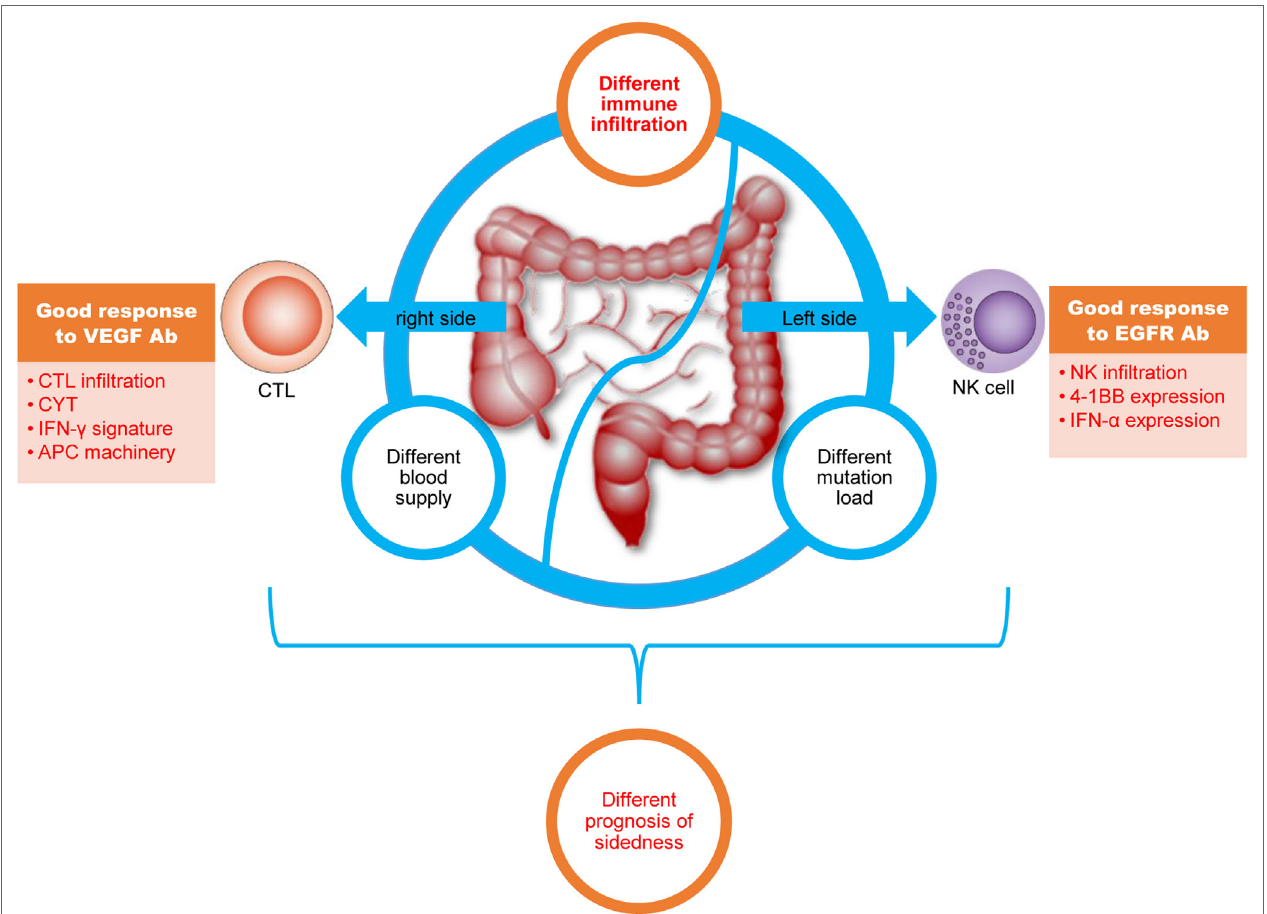
FigUre 5 | The colorectal cancer (CRC) immune landscape and implications for immunotherapy. Right-side colon (cecum to transverse colon) cancer and left colorectal (splenic flexure to rectum) cancer have different mutation loads, immune infiltration, and blood supplies; furthermore, different immune cell infiltration profiles, signaling pathways, and effector molecule in right-side colon cancer and left-side CRC might lead to different treatment responses. All of these differences might lead to different prognoses with